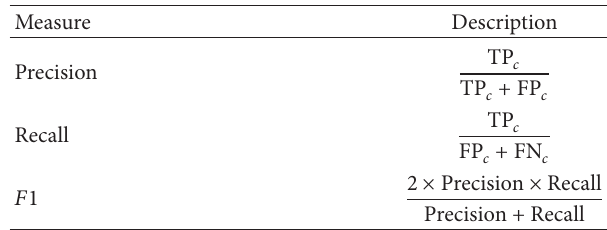
Table 2: Evaluation